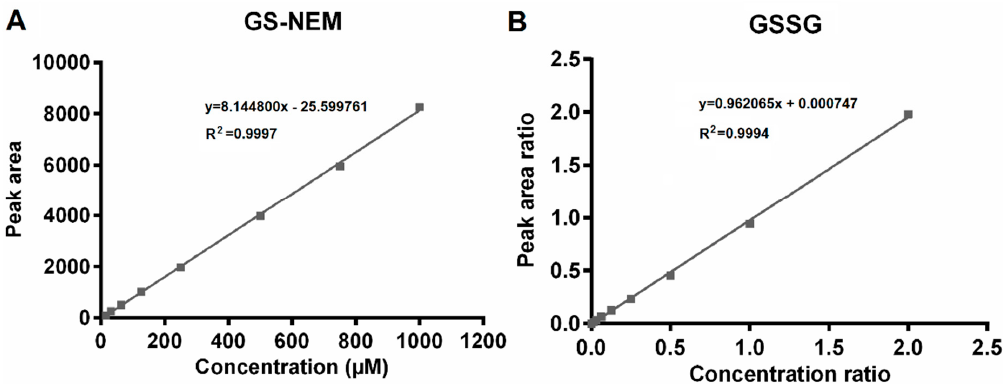
Figure 2. Calibration curves for GS-NEM and GSSG. ( A ) A nine-point GS-NEM calibration curve was